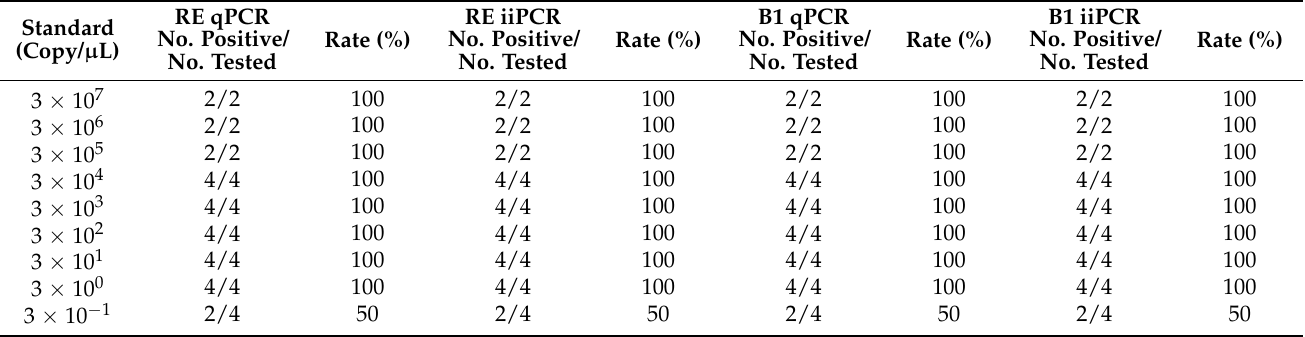
Table 3. Analytical sensitivity of singleplex